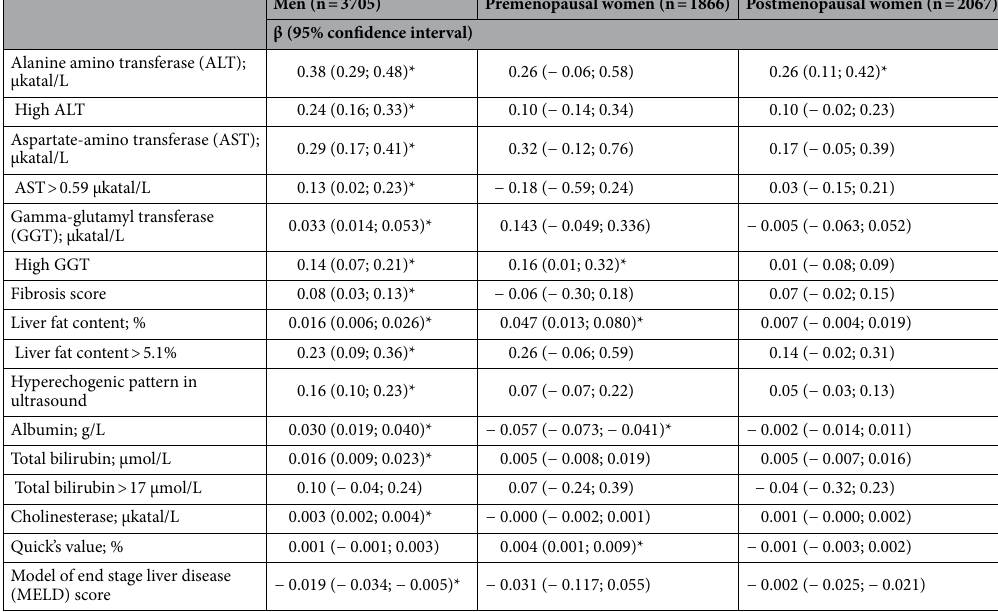
Table 2. Association of liver biomarkers with homoarginine. Results are derived from linear regression models with serum homoarginine levels as outcome adjusted for age, waist circumference, alcohol consumption, physical activity, triglycerides, HDL-cholesterol, serum creatinine, and study. Analyses were conducted for each exposure separately. *p < 0.05.